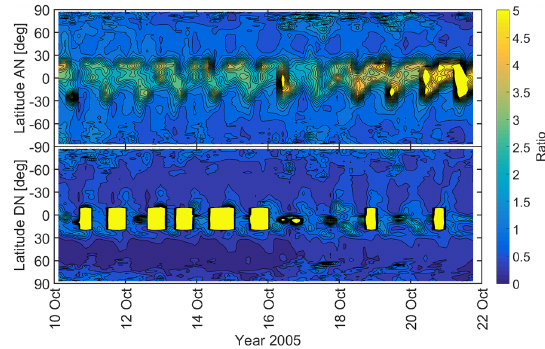
Figure 18. Electron density ratio (GITM / CHAMP) as a function of time and latitude for “case c” (LTAN = 06:44; LTDN = 18:44).